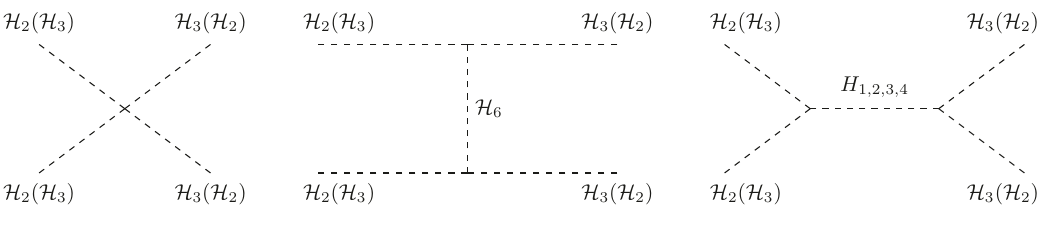
Figure 8 . Dominant contributions to annihilation of the two-component scalar dark matter into standard model particles.